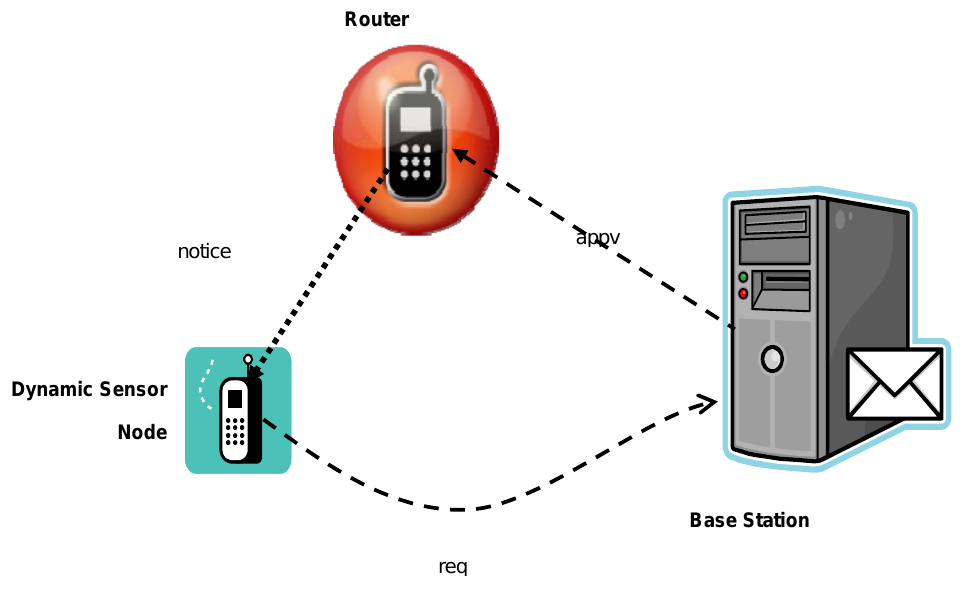
Figure 2. The basic architecture and message flow of our